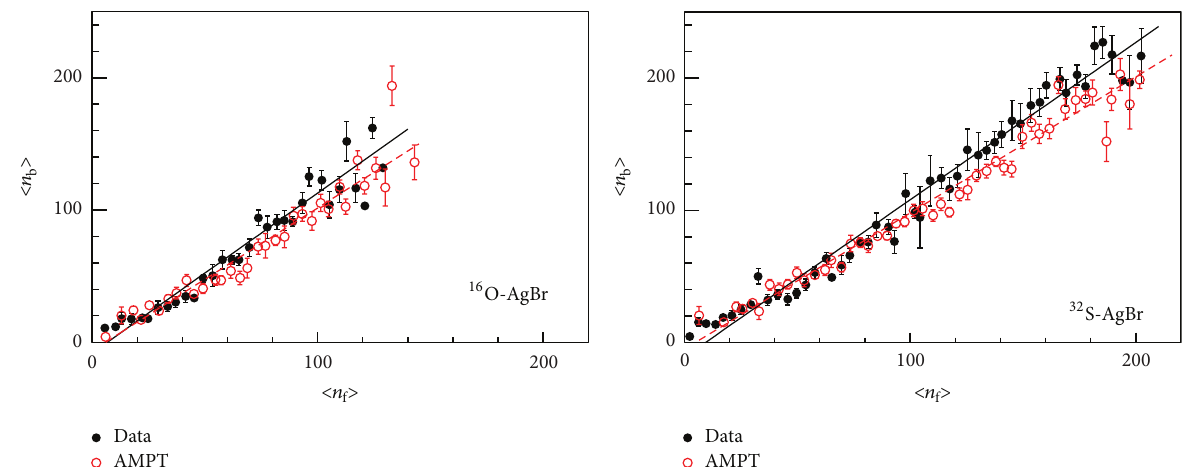
⟩ with 𝑛 Figure 2: Variations of ⟨𝑛 for 16 O- and 32 S-AgBr collisions. The straight lines represent the best fit to the data obtained using (1). b f